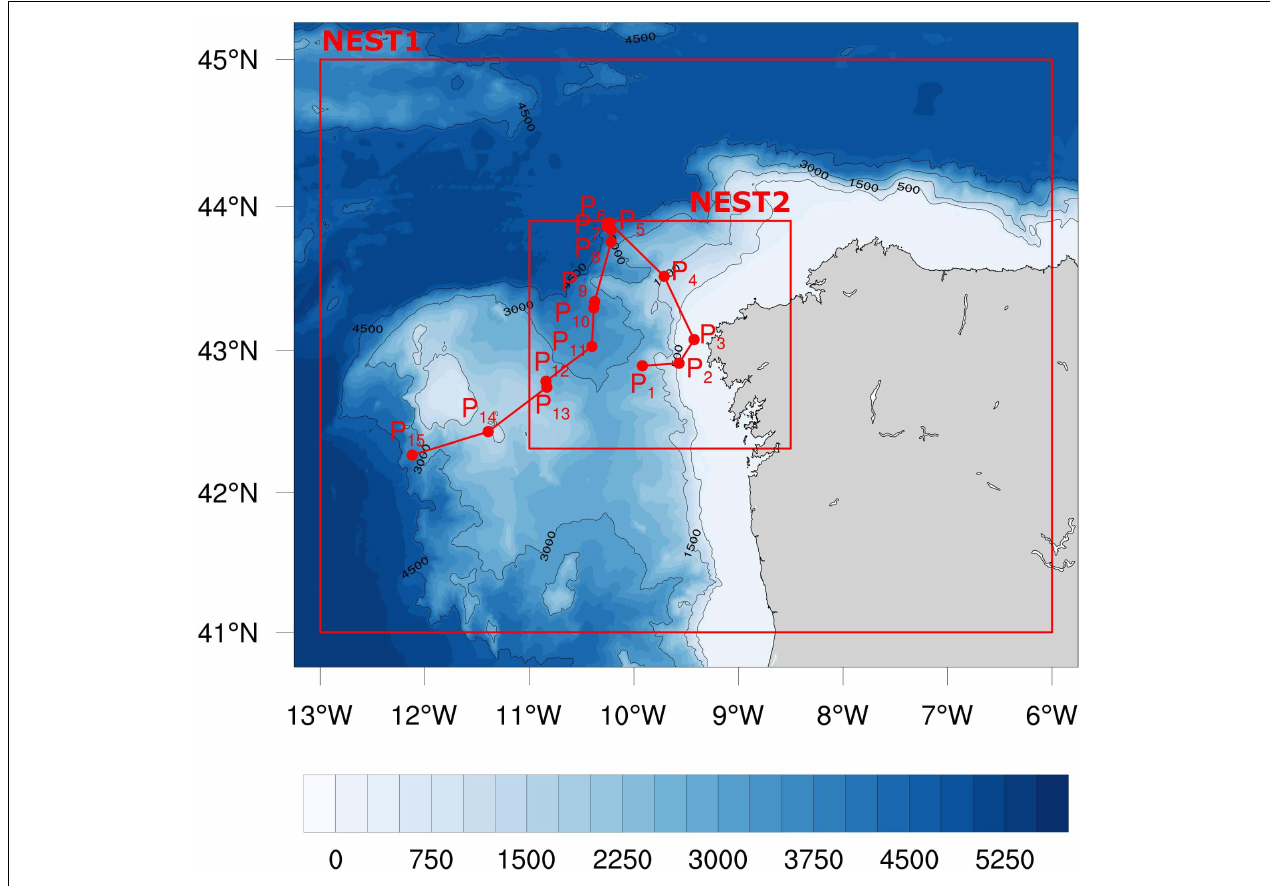
FIGURE 8 | Bathymetry contour map of the Prestige experiment area. Red rectangles delineate the boundaries of the two consecutive nested domains with increasing grid resolutions of 2000 and 500 m (from the outer to the inner domains). Red dots denote the Prestige Ship’s positions from the initial spill (P 1 ) on 13-11-2002 15:10 to the final breaking up (P 15 ) on 19-11-2002 08:00. The list of the Prestige’s positions are reported in Table 1 .